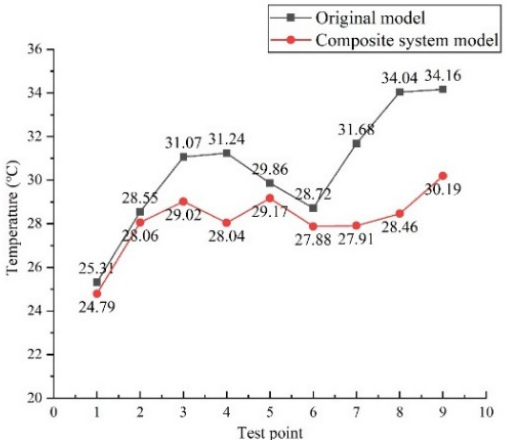
Figure 9. The exhaust air temperatures of the 9 different points in the rack B4 of these two models with the original and new cooling systems.